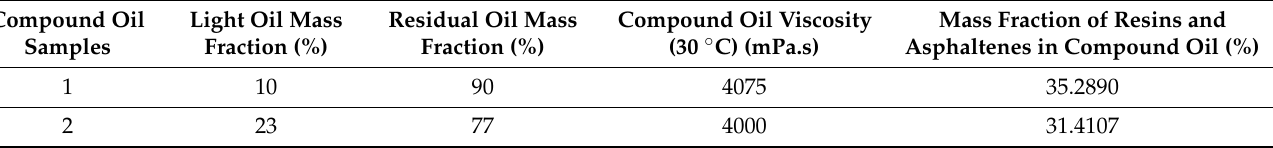
Table 2. Content of heavy components and viscosity of compound